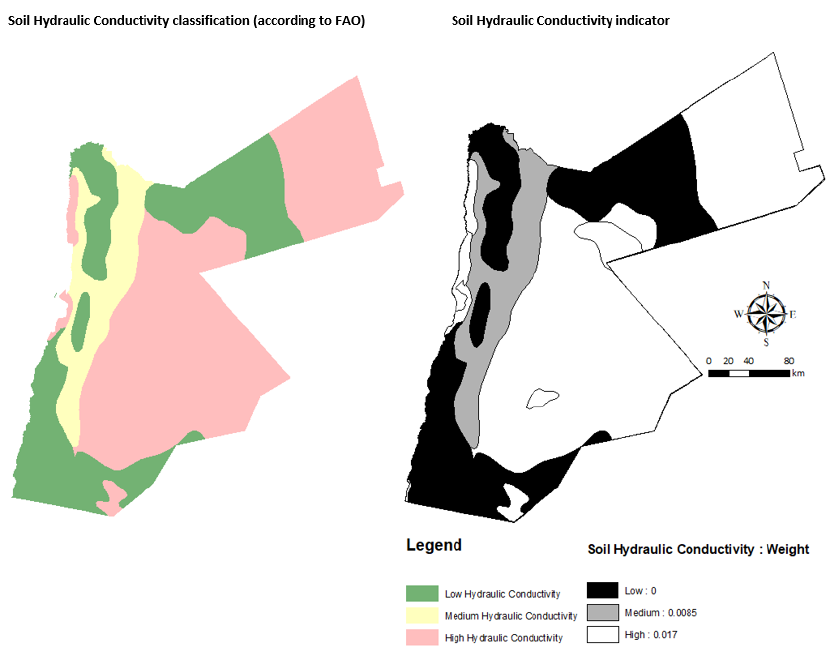
Figure 10. Soil Hydraulic Conductivity Indicator.